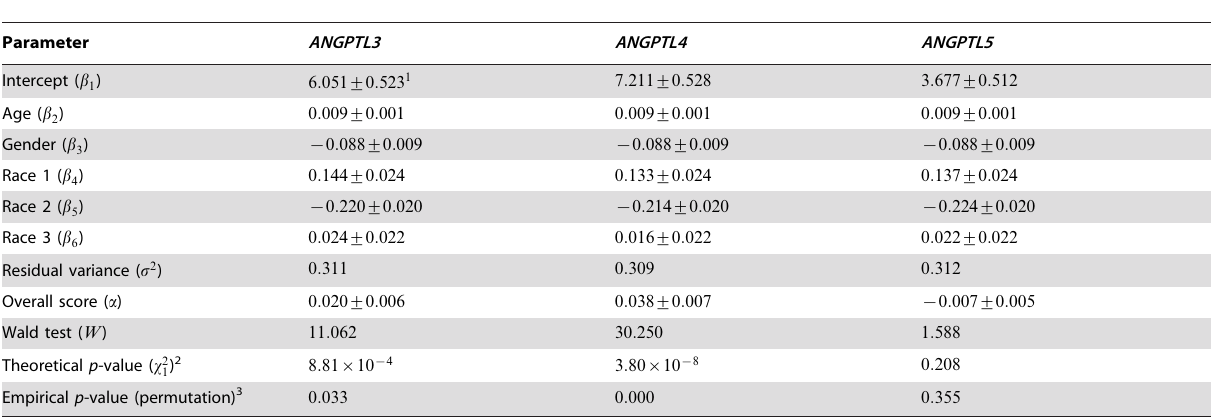
Table 2. Parameters of three genes of the Dallas Heart Study estimated separately using the BhGLM